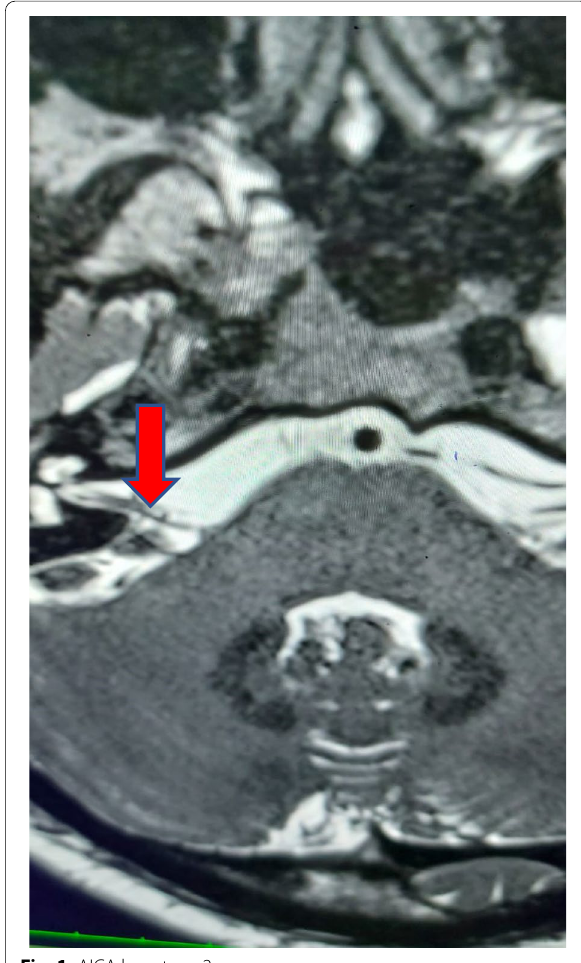
Fig. 1 AICA loop type 2